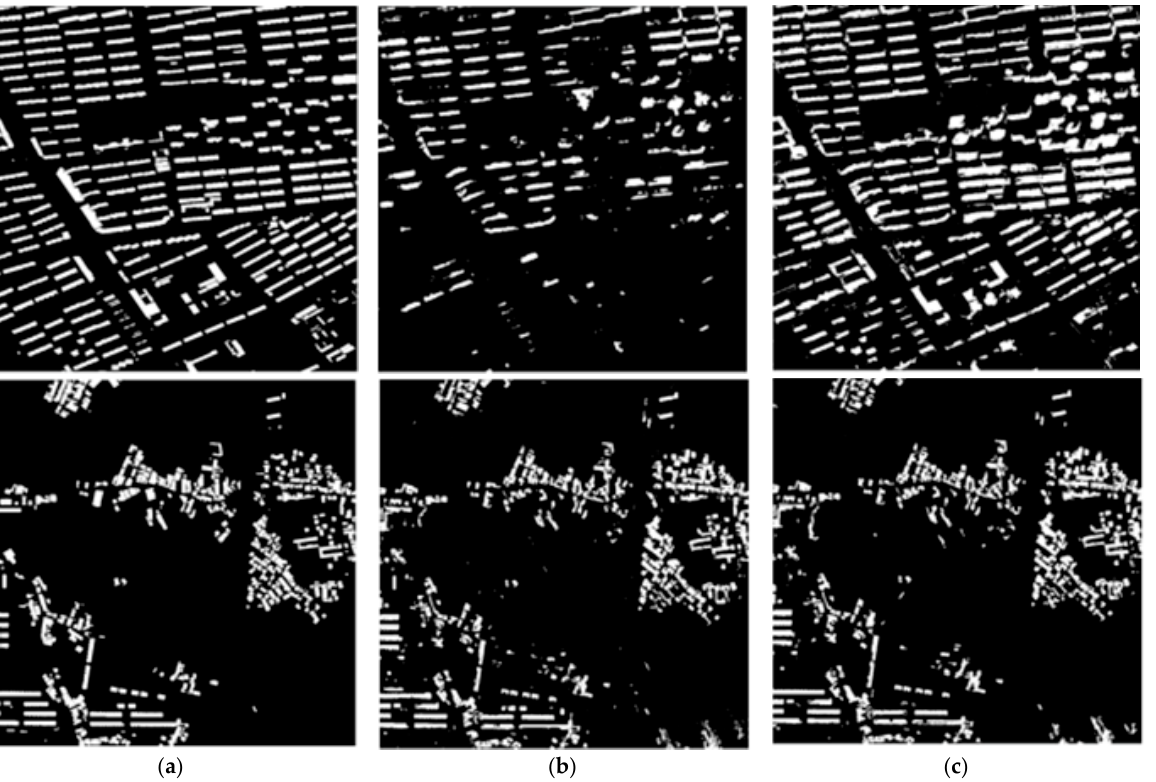
Figure 5. Semantic segmentation results on the larger areas. The white area indicates the building footprint. ( a ) Ground truth. ( b ) Results by using the only pre-trained model based on the UNet model. ( c ) Results of our framework with the UNet model.